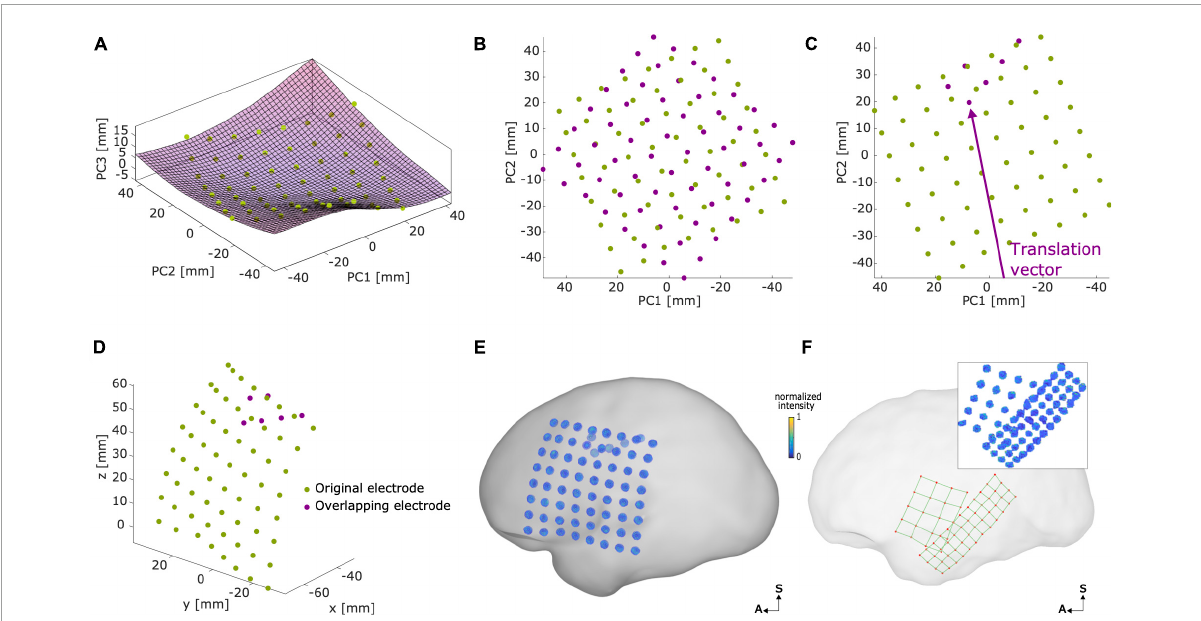
FIGURE3 Modeling overlapping grids. Example of an overlapping grid in an 8 × 8, 10 mm, IED case. (A) Original electrode coordinates (green) were transformed into the principal component space, where a surface ( S fit ) was fitted to the coordinates. (B) In a 2D space defined by PC1 and PC2, the overlapping grid (magenta) was defined with a random orientation. (C) The overlapping grid was translated (in the arrow direction) until the desired number of overlapping electrodes was achieved. (D) Coordinates were back-projected to the original 3D space surface. (E) Voxel artifacts were simulated in the new overlapping grid electrode coordinates, overlaying the SCE surface. Voxel artifacts’ orientations were interpolated from close-by electrodes of the original array. (F) Example of real overlapping grids (5 × 4, 10 mm IED and 4 × 12, 6 mm IED) overlaying the left SCE surface. The inset shows the corresponding thresholded CT artifact voxels. Plots (B,C) show the PC1 axes direction inverted for illustrative purposes. IED, inter-electrode distance; SCE, smooth cortical envelope; A, anterior; S,